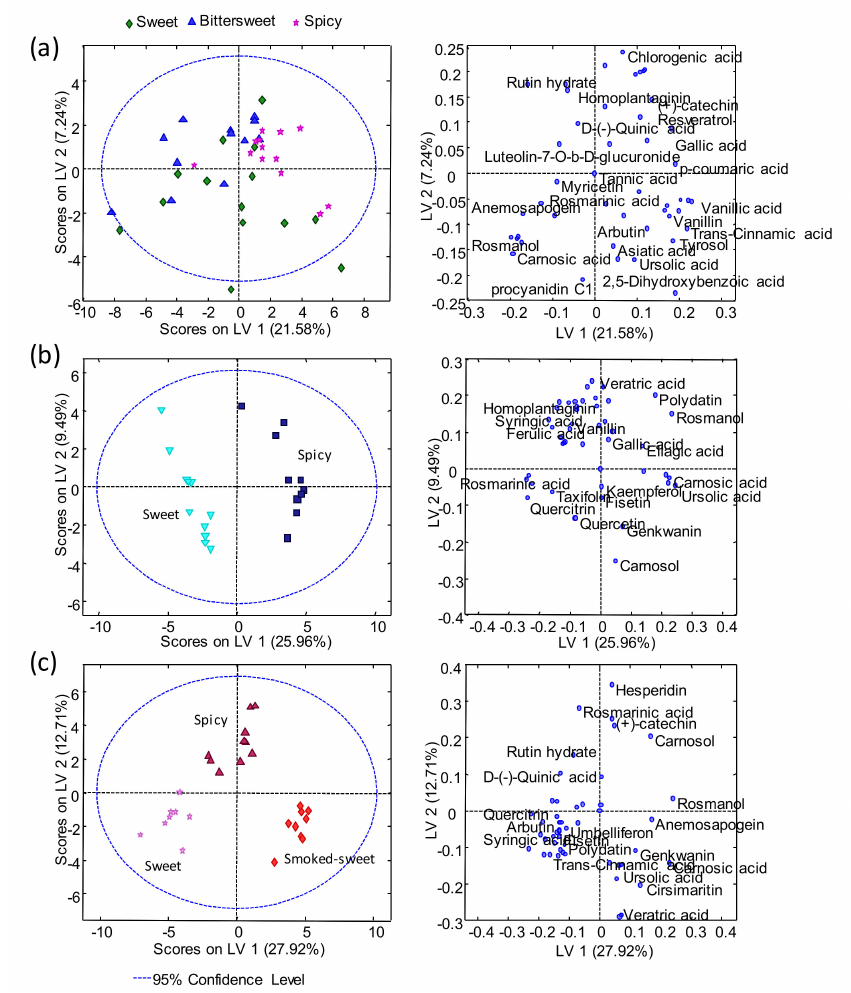
Figure 5. Partial least squares regression-discriminant analysis (PLS-DA) score and loading plots for ( a ) La Vera PDO paprika samples, ( b ) Murcia PDO paprika samples, and ( c ) the Czech Republic paprika